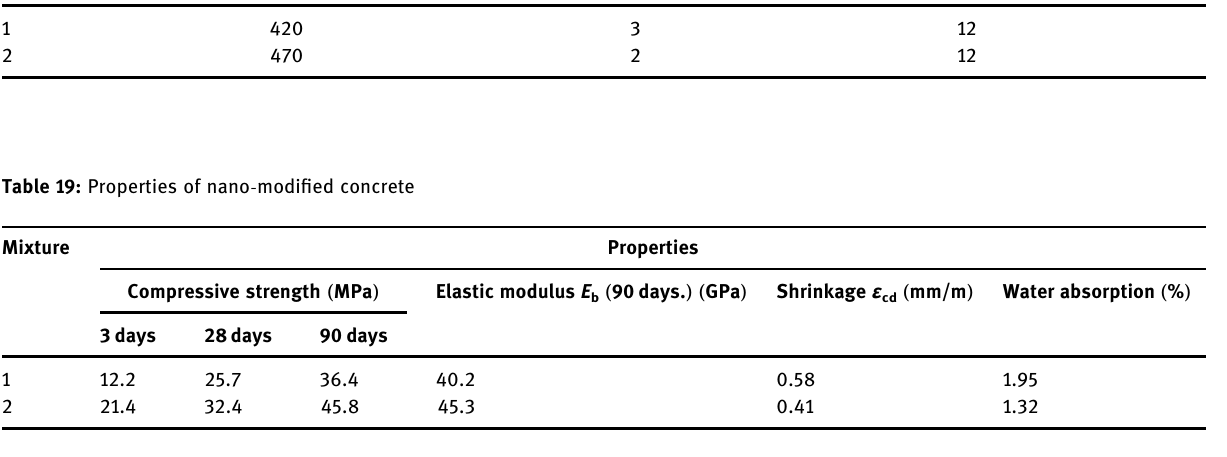
Table 18: Indicators of fl owability of concrete mixes Composition No.